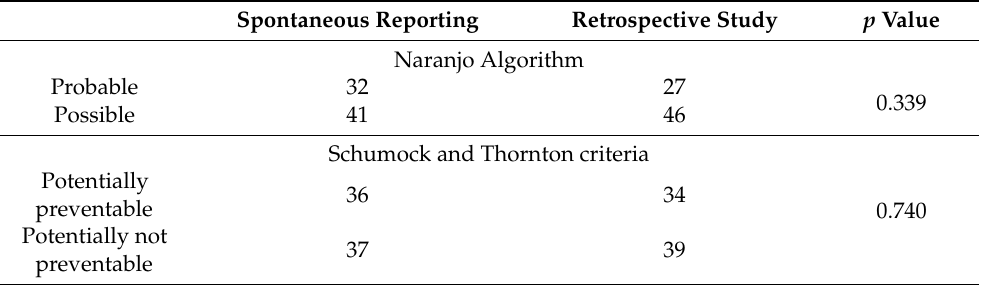
Table 12. Comparison of causality assessment and